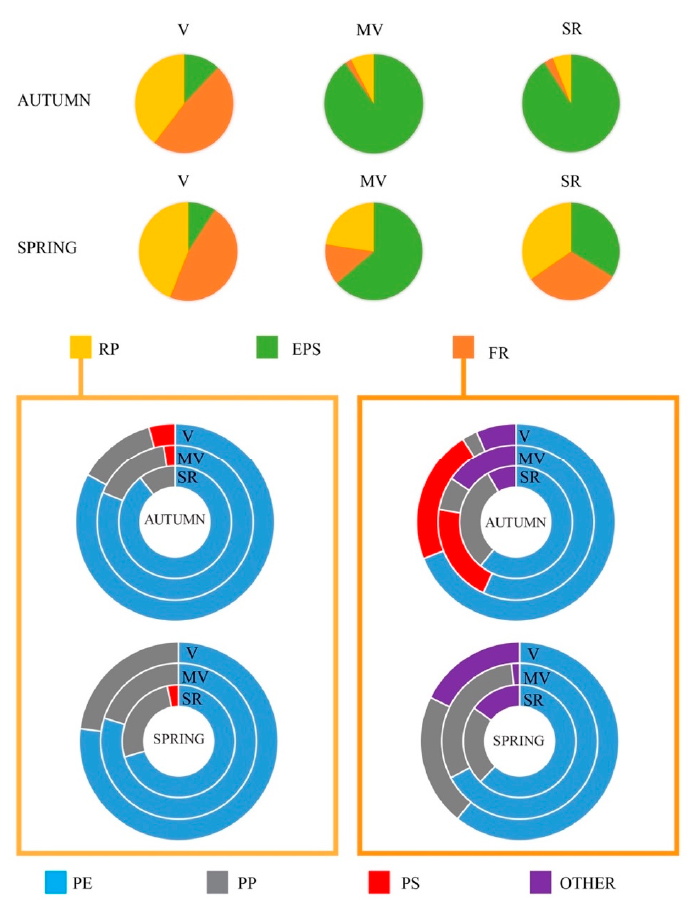
Figure 8. Pie charts of the main polymers of which the FR and RP are composed, divided by site (SR, MV, V) and season (spring and autumn). Data are available in Table S7 in Supplementary Material. Polyethylene (PE) dominated all the samples, followed by Polypropylene (PP) and, particularly